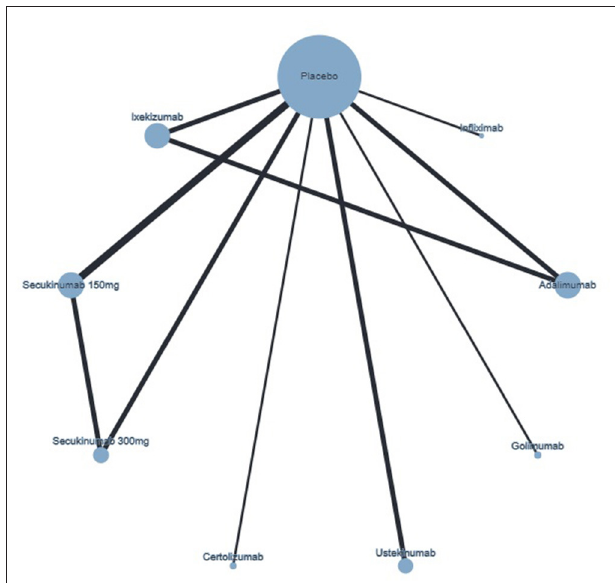
FIGURE 3 | Network plot of ACR70 response showing direct comparisons, at week 24. The width of the edge is proportional to the number of studies, and the node size is proportional to the sample